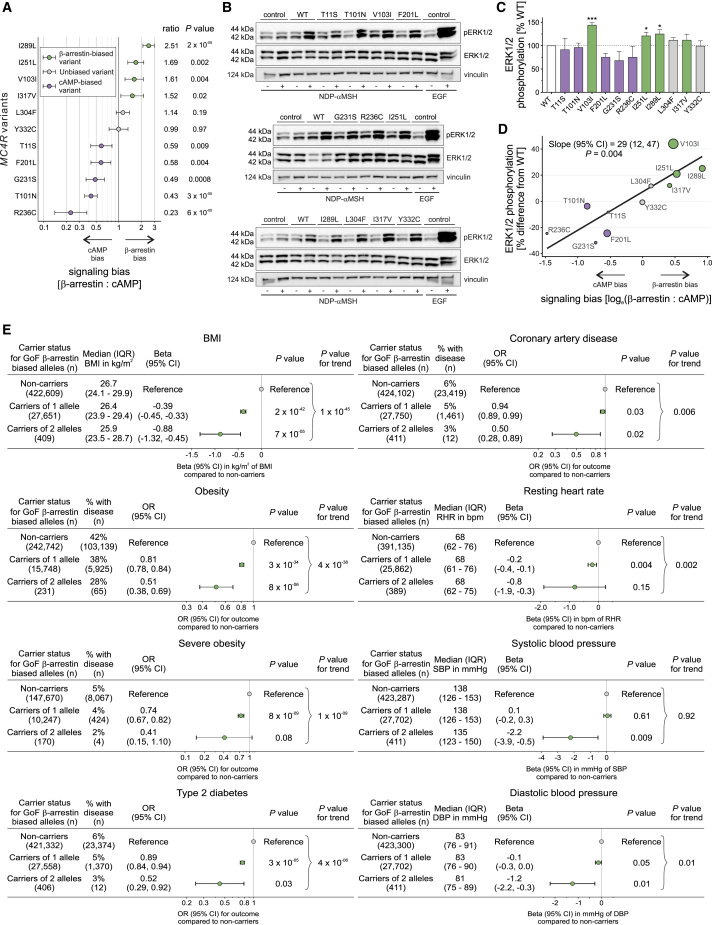
Gain-of-Function MC4R Variants that Exhibit Bias toward β-Arrestin-Mediated Signaling Protect against Obesity and Its Complications(A) Signaling bias for 11 GoF MC4R mutants calculated as ratio (95% CI) of geometric means for maximal activity of β-arrestin to cAMP; data from 4–12 experiments. The null hypothesis of no bias (ratio = 1) was tested using unpaired two-sample t test. Variants were classified as biased toward β-arrestin (green), biased toward cAMP (purple), or unbiased (gray).(B and C) (B) Representative western blots and (C) quantification of ERK1/2 phosphorylation (expressed as % WT) before (−) and after (+) NDP-αMSH stimulation of GoF MC4R mutants; epidermal growth factor (EGF) used as a positive control; vinculin used as a loading control. Data represented as mean ±SEM from 3–8 independent experiments; statistical significance of differences between WT and mutant (unpaired single-sample t test).(D) Meta-regression analysis showing that greater bias for β-arrestin recruitment predicts greater ERK1/2 phosphorylation for GoF variants (depicted as circles with size proportional to precision in ERK1/2 phosphorylation estimates).(E) Associations with BMI, obesity, severe obesity, type 2 diabetes, coronary artery disease, resting heart rate (RHR) in beats/min (bpm), and systolic and diastolic blood pressure (SBP and DBP, respectively) in millimeters of mercury (mmHg) by carrier status for β-arrestin-biased GoF MC4R alleles.OR, odds ratio; CI, confidence interval; IQR, interquartile range; n, number of participants. See also Tables S6 and S7.